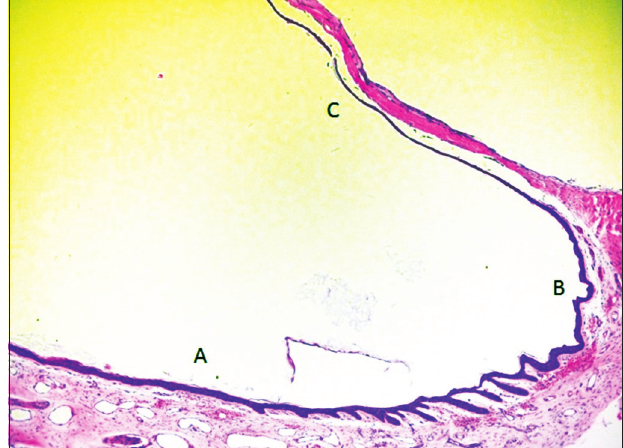
Figura 5. Fotomicrografia mostrando o epitélio da porção inferior do meato acústico externo (A), anel fibrocartilagíneo (B) e membrana timpânica (C) (HE – 50x). Observar a presença de cones epiteliais na epiderme da parede inferior do meato acústico externo, próximo ao anel fibrocartilagíneo.